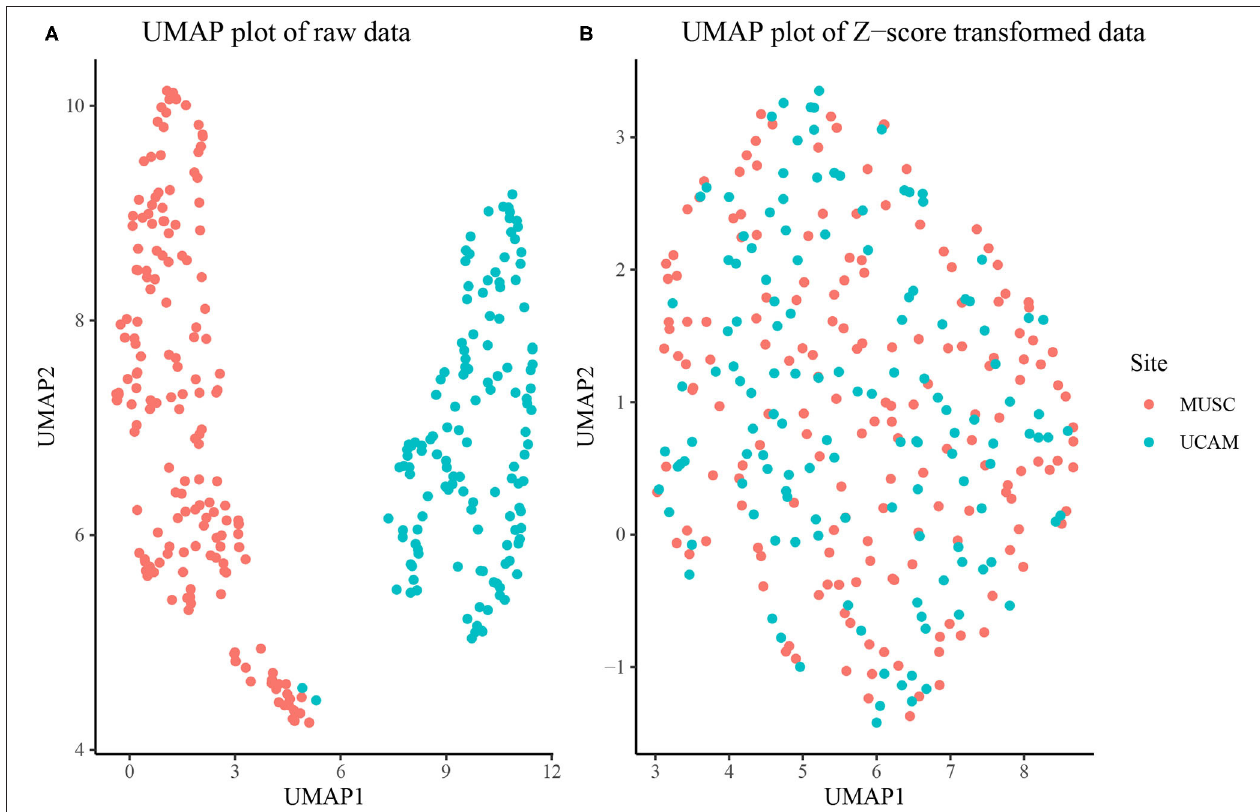
Figure 5A plots the